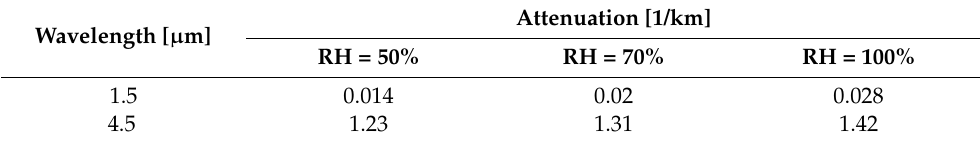
Table 3. Attenuation coefficient by air relative humidity (HITRAN